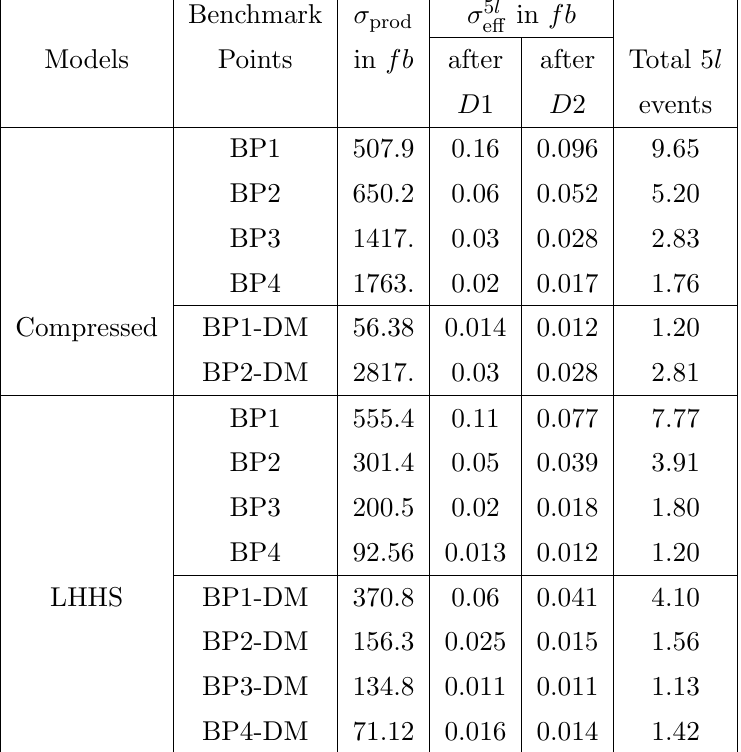
for the BPs de(cid:12)ned in table 4 e(cid:11)